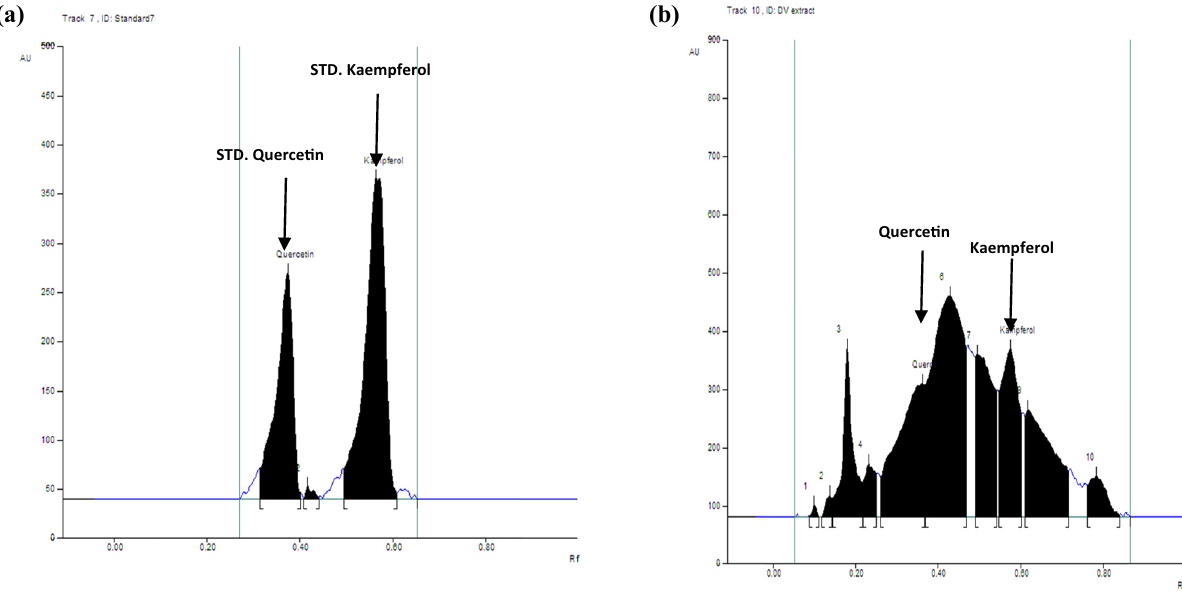
Figure 5: ( a ) Chromatogram of standards quercetin ( Rf = 0.38 ) , kaempferol ( Rf = 0.58 ) ( mobile phase: toluene: ethyl acetate: formic acid [ 5:4:0.2; v/v/v ] at 254 nm ) ; ( b ) chromatogram of estimation quercetin and kaempferol in D. viscosa extract.